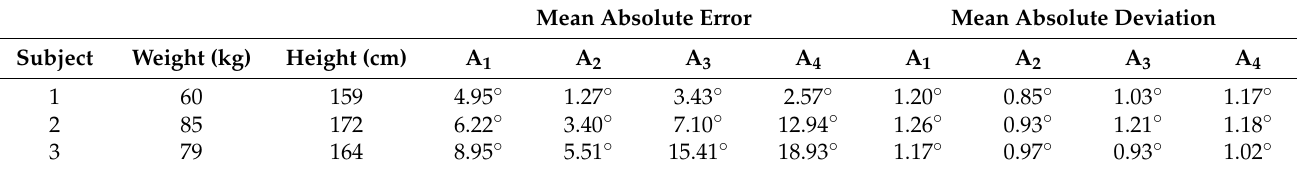
Table 2. MAE and MAD for each subject considering the differences for the three speeds (4.0 km/h, 4.5 km/h and 5